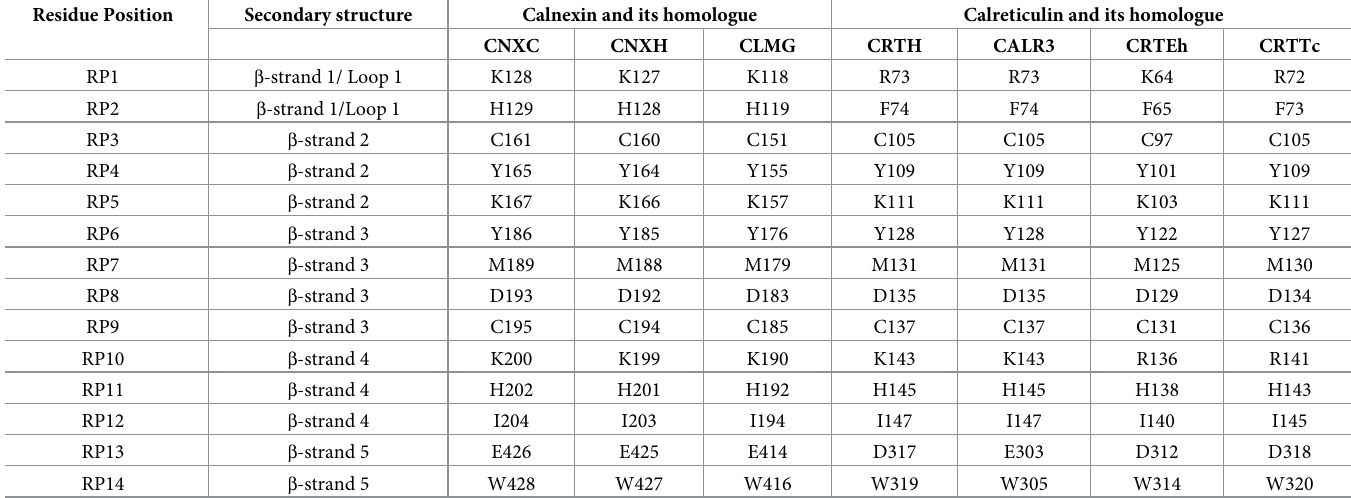
Table 2. Sequence and structurally conserved residues in the calreticulin family of proteins.